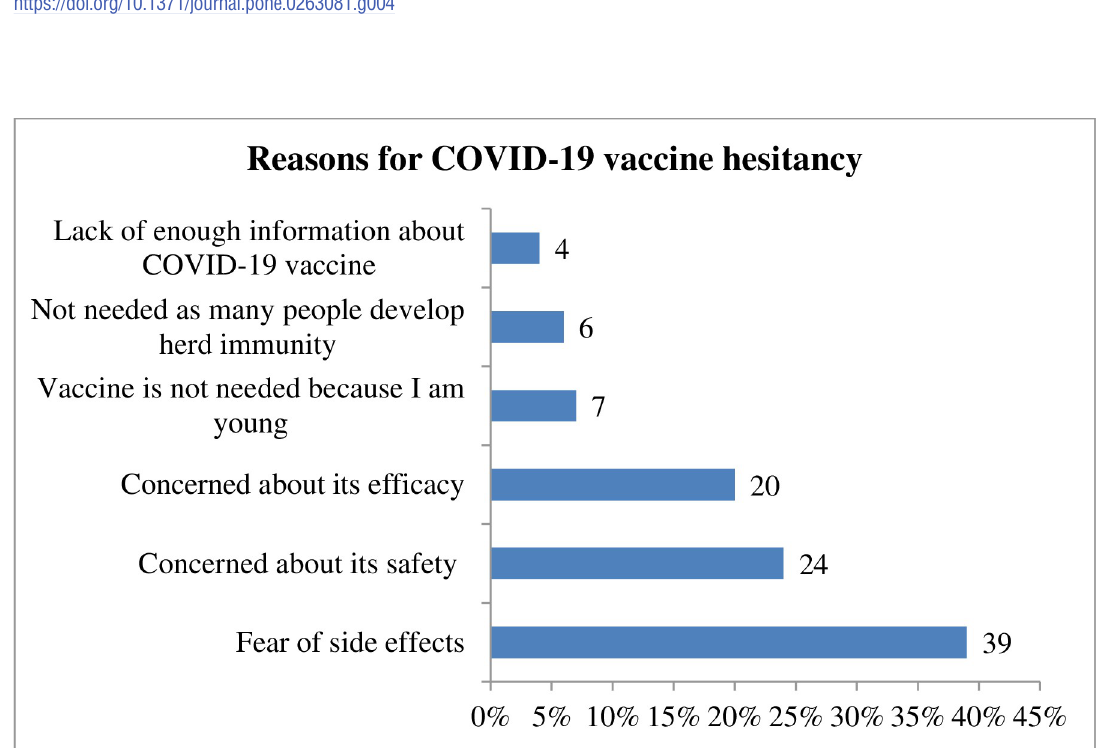
Fig 5. Reasons of COVID-19 vaccine hesitancy among medical and health science students attending Wolkite University, Ethiopia, 2021 (n = 173).